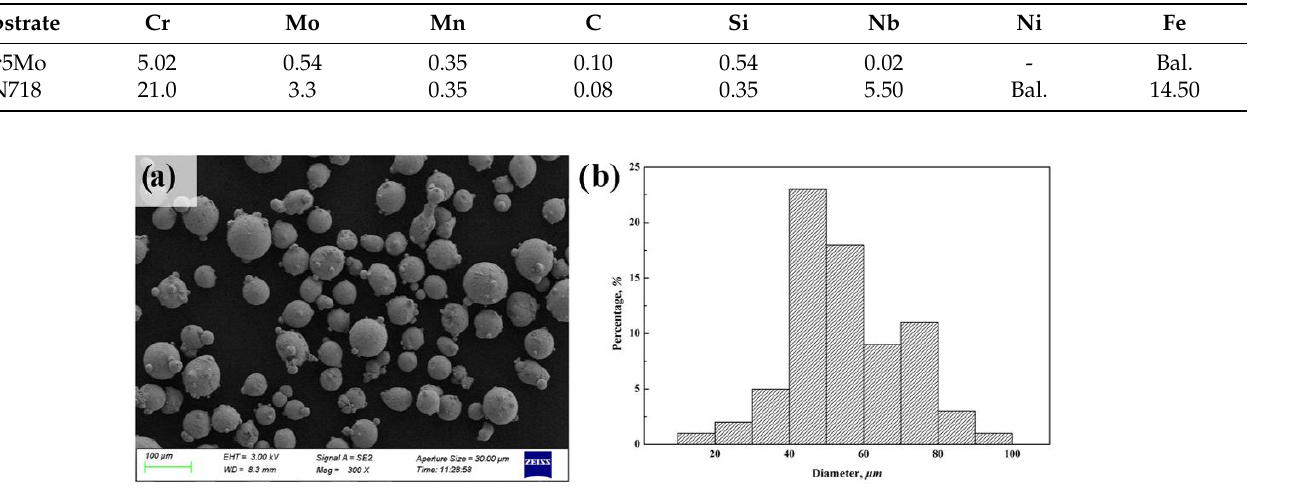
10 Figure 2. Preparation of laser cladding samples with different parameters on Cr5Mo.